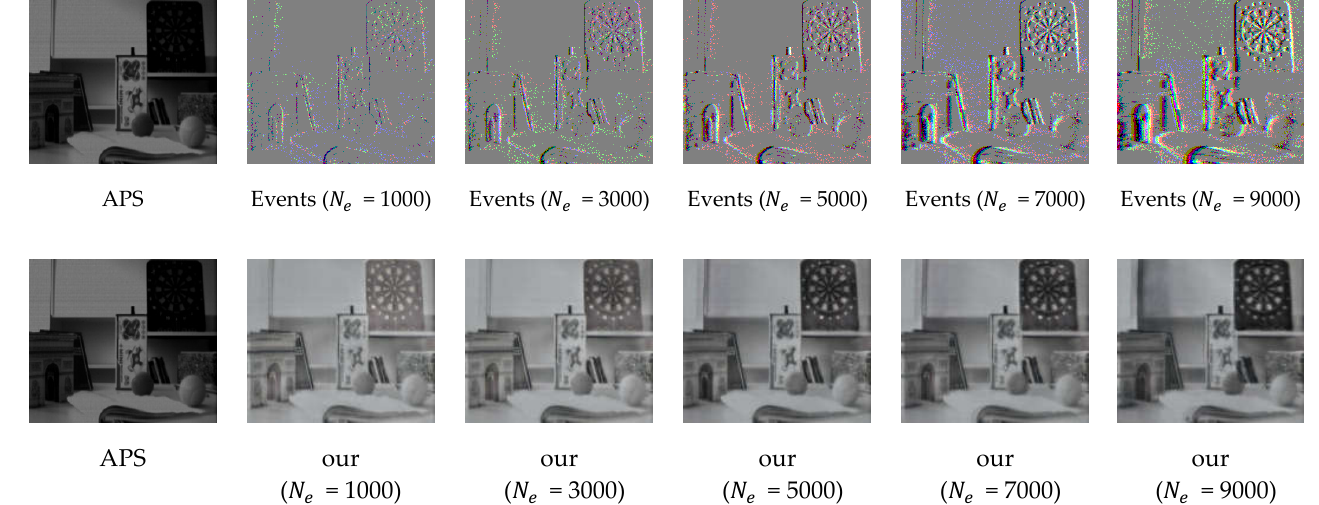
Figure 9. The effects of different values of N e on event stacks and reconstructed images are qualita- tively compared. The APS frame is upsampled with bicubic interpolation to the corresponding scale for reference.